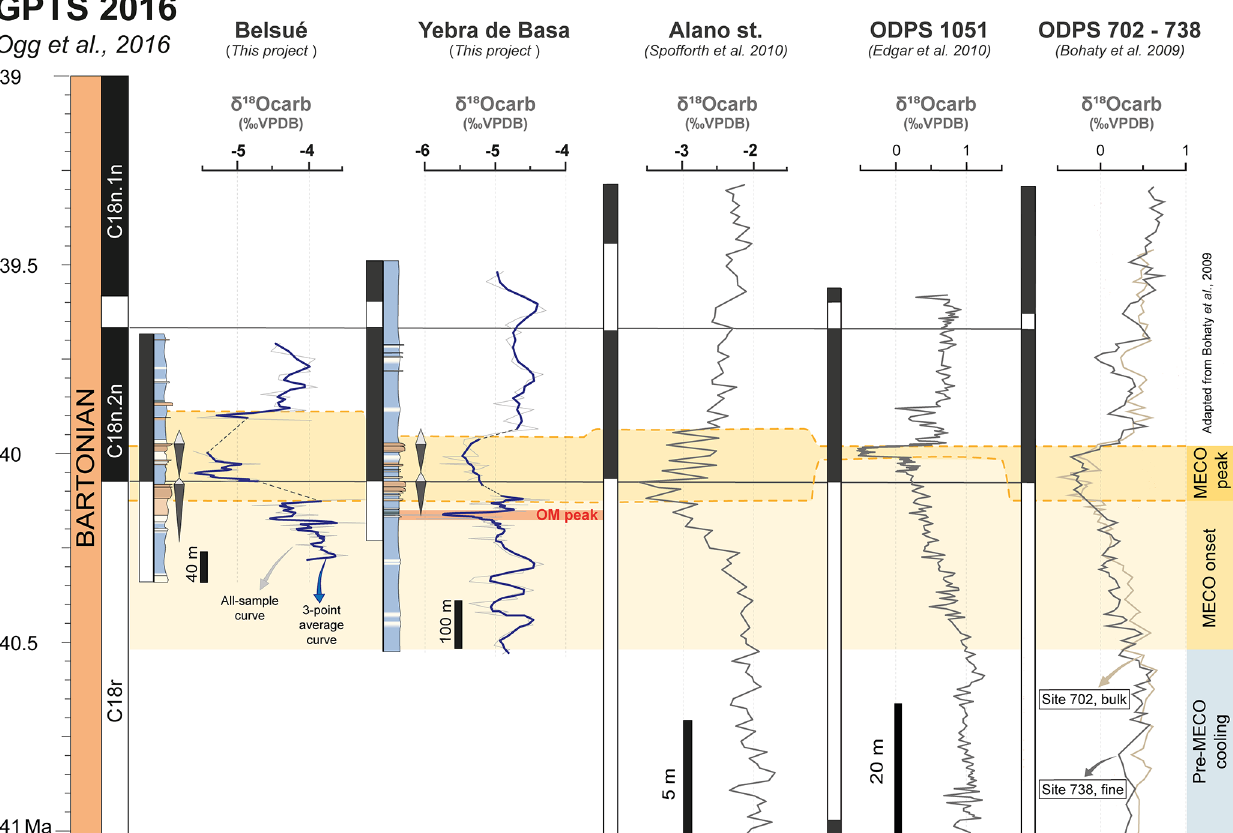
Figure 9. Oxygen isotope ( δ 18 O carb ) correlation panel for the studied sections (Belsué and Yebra de Basa) with MECO target curves from Alano (Italy, Tethys Ocean; Spofforth et al., 2010), ODPS 1051 (N Atlantic Ocean; Edgar et al., 2010), ODPS 702 (S Atlantic Ocean; Bohaty et al., 2009), and ODPS 738 (S Indic Ocean; Bohaty et al., 2009). Data from the bulk- and fine-sediments fractions. Highlighted in red is the OM-rich interval (TOC peak) in Yebra de Basa. The two progradation–retrogradation cycles referred to in the text are drawn with grey and white triangles. The data are scaled according to magnetostratigraphic tie points, between C18r–18n.2n and C18n.2n–C18n.1r chrons.